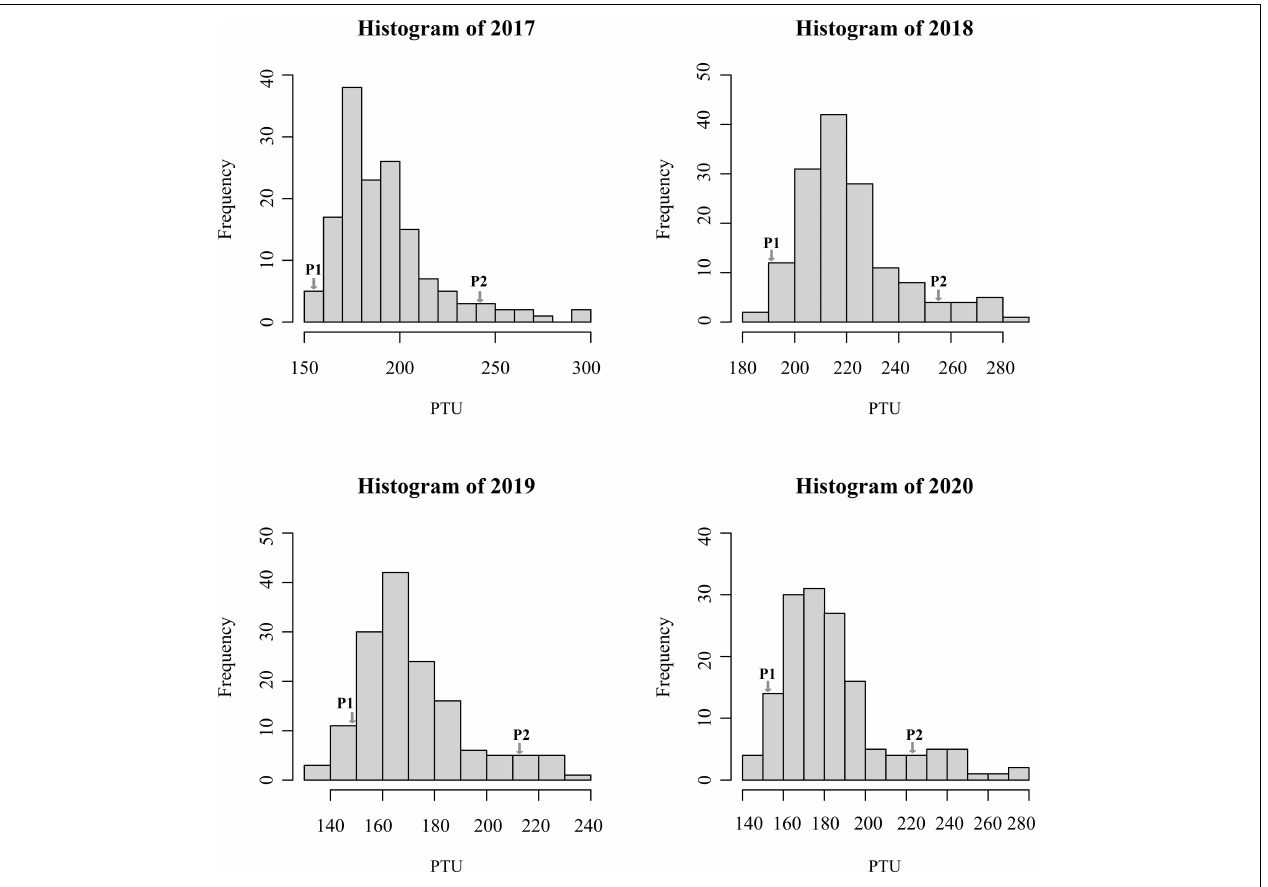
FIGURE 1 | Frequency distributions of photothermal unit values in the F 1 population at Langfang, Hebei Province from the year 2017 to 2020.